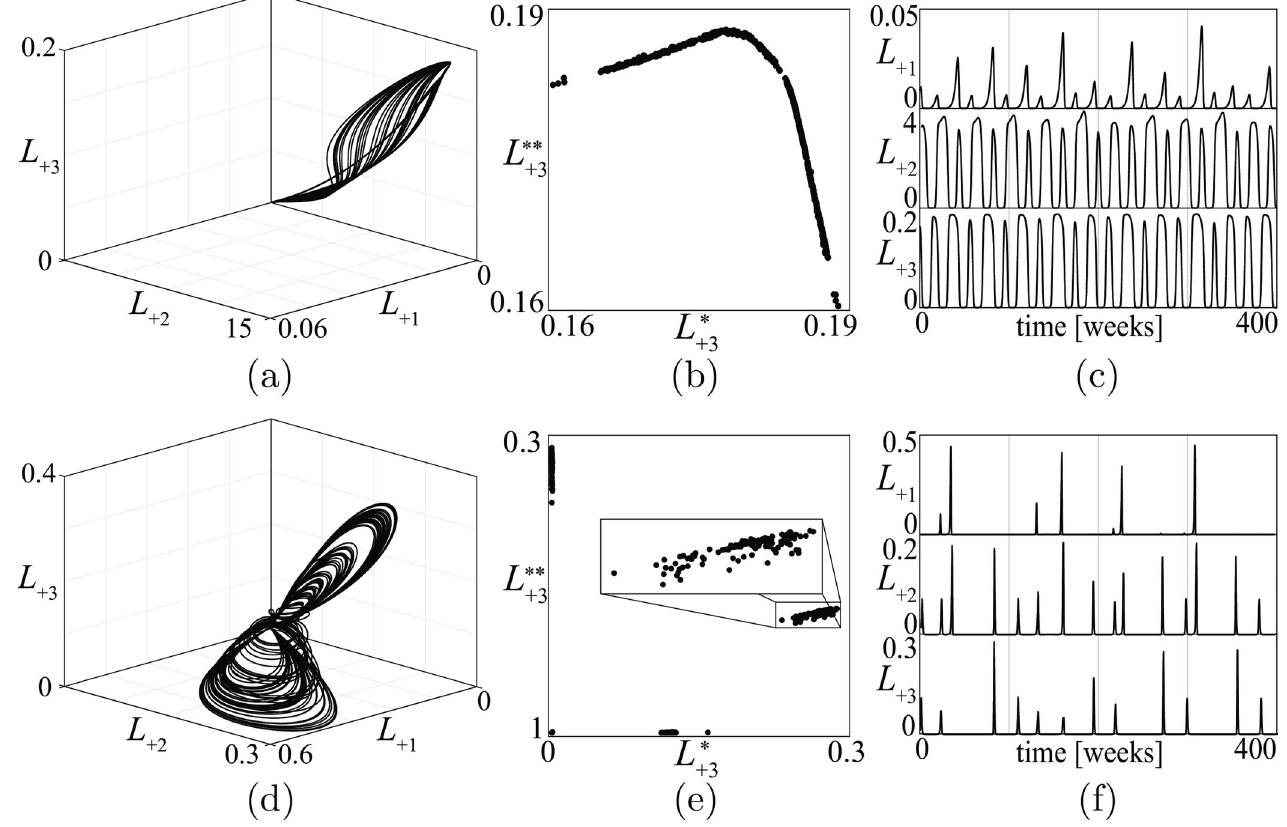
Fig 17. Aperiodic stalemates in conflicts between three groups. Top: quasi-periodic stalemate for a conflict of type (6) in Fig 13. Bottom: chaotic stalemate for a conflict of type (9) in Fig 13.